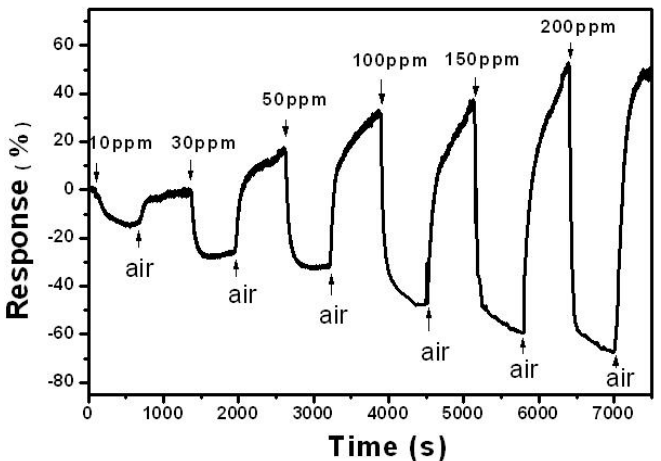
Figure 3. Response of SnO -PDDAC sensor to ethanol of different 2